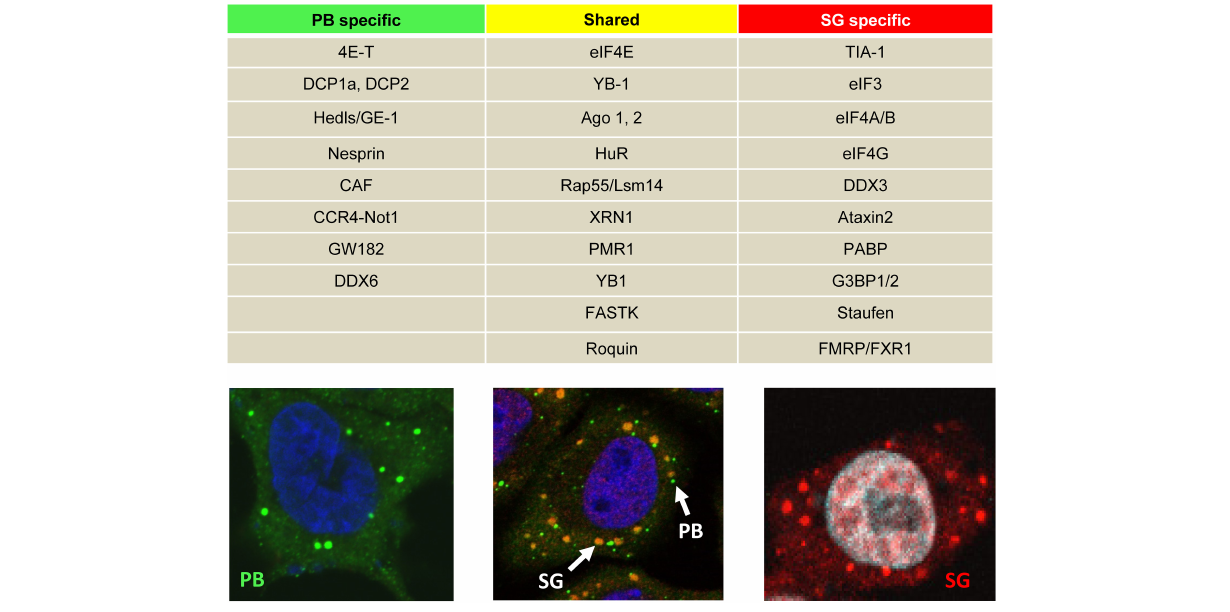
components of the host cell antiviral response (Zhang et